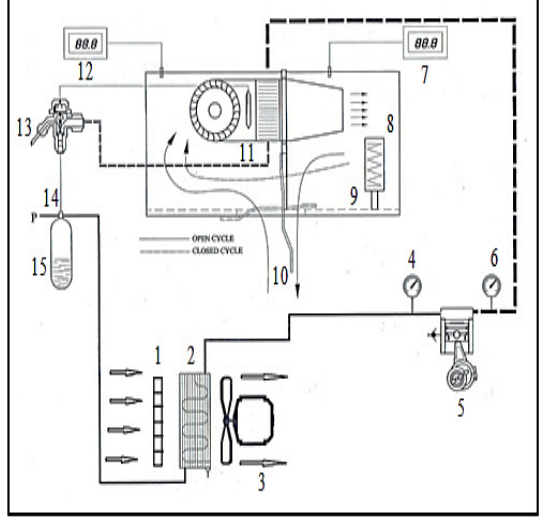
Fig. 2. Instruments of automobile air conditioner training unit: 1-Air guide net, 2- Condenser, 3- Condenser fan, 4-Low pressure manometer,5- Compressor, 6-High pressure manometer, 7-Indoor temperature display, 8-Electrical resistance (human body heat simulator, 9-Low pressure switch, 10- Control board, 11-Evaporator, 12-Outdoor temperature display, 13-Therostatic expansion valve, 14-Low pressure switch, 15-Filter drier.